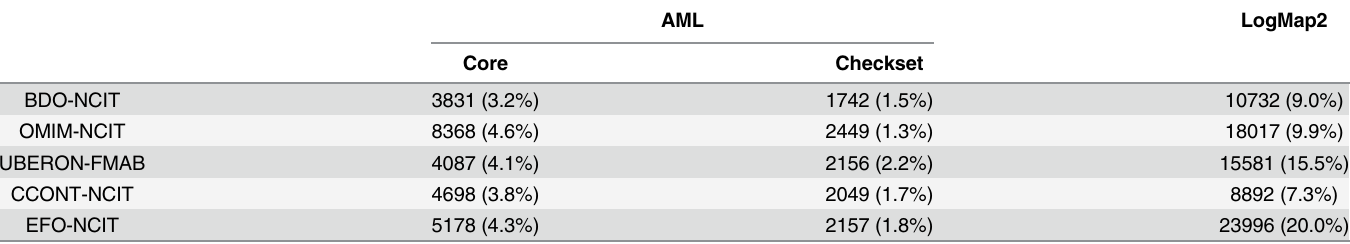
Table 6. Number of classes in AMLR ’ s core fragments and checksets, and in LogMap's extracted modules for five Bioportal alignments. The per- centage of classes relative to the original ontologies is shown in